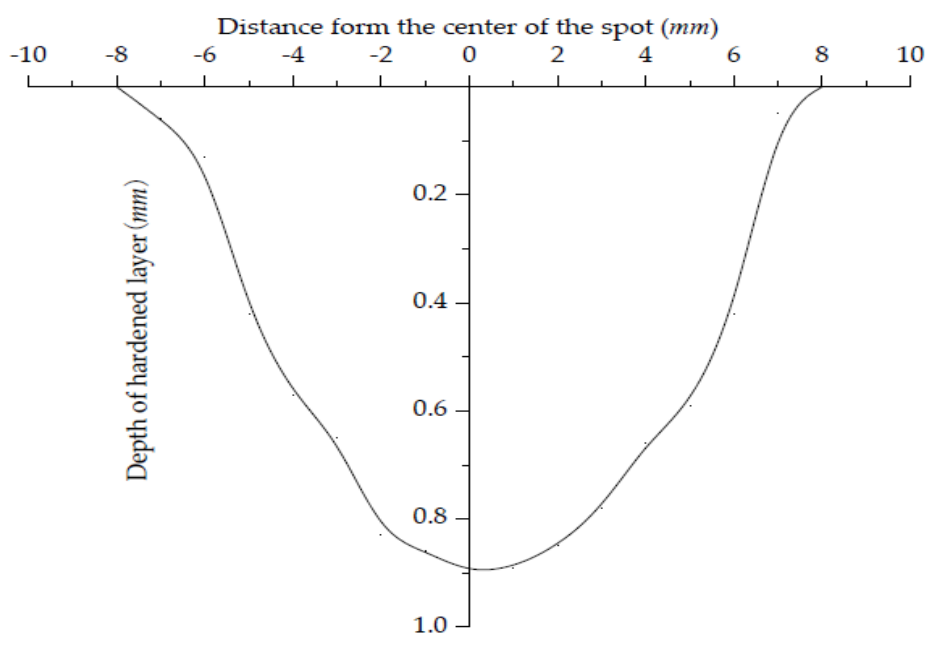
Figure 5. Hardened layer distribution curve.